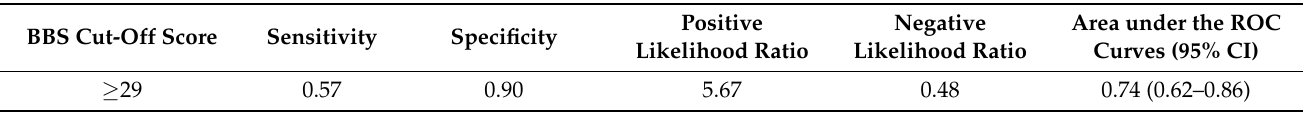
Table 3. The optimal Berg Balance Scale cut-off scores at admission for community ambulation at discharge determined from the ROC